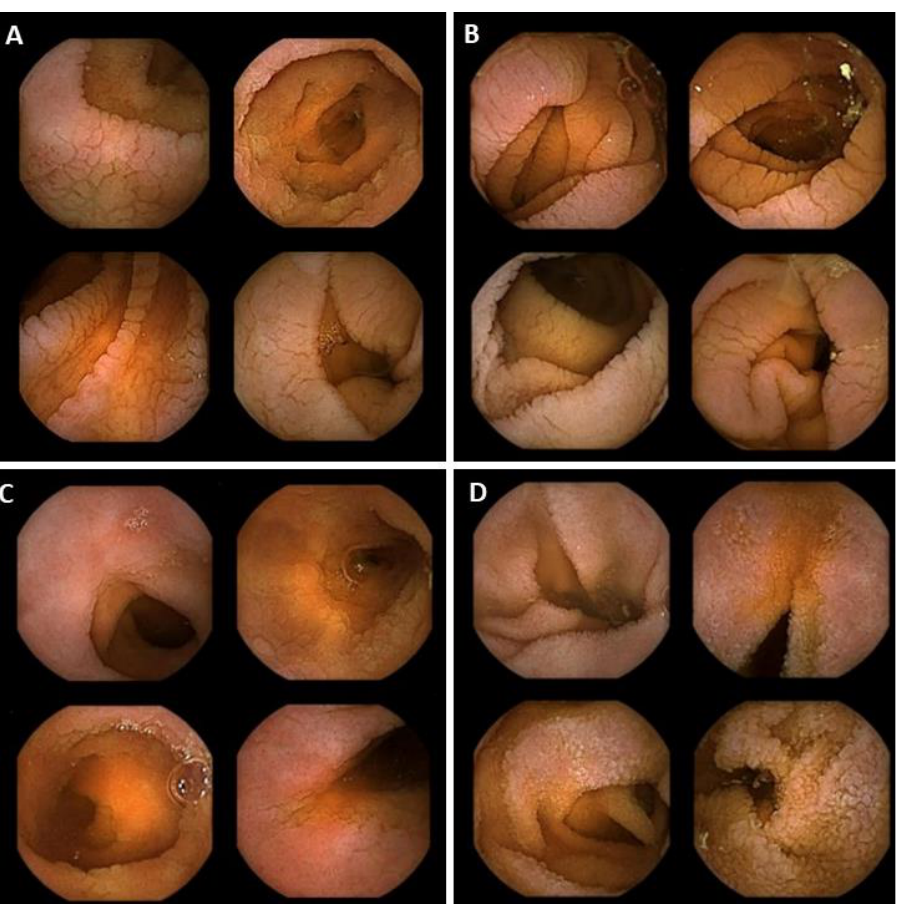
Figure 2. Agreed images representing the endoscopic findings suggestive for villous atrophy: mo- saicism ( A ), scalloping ( B ), folds reduction ( C ), and granular mucosa ( D ).